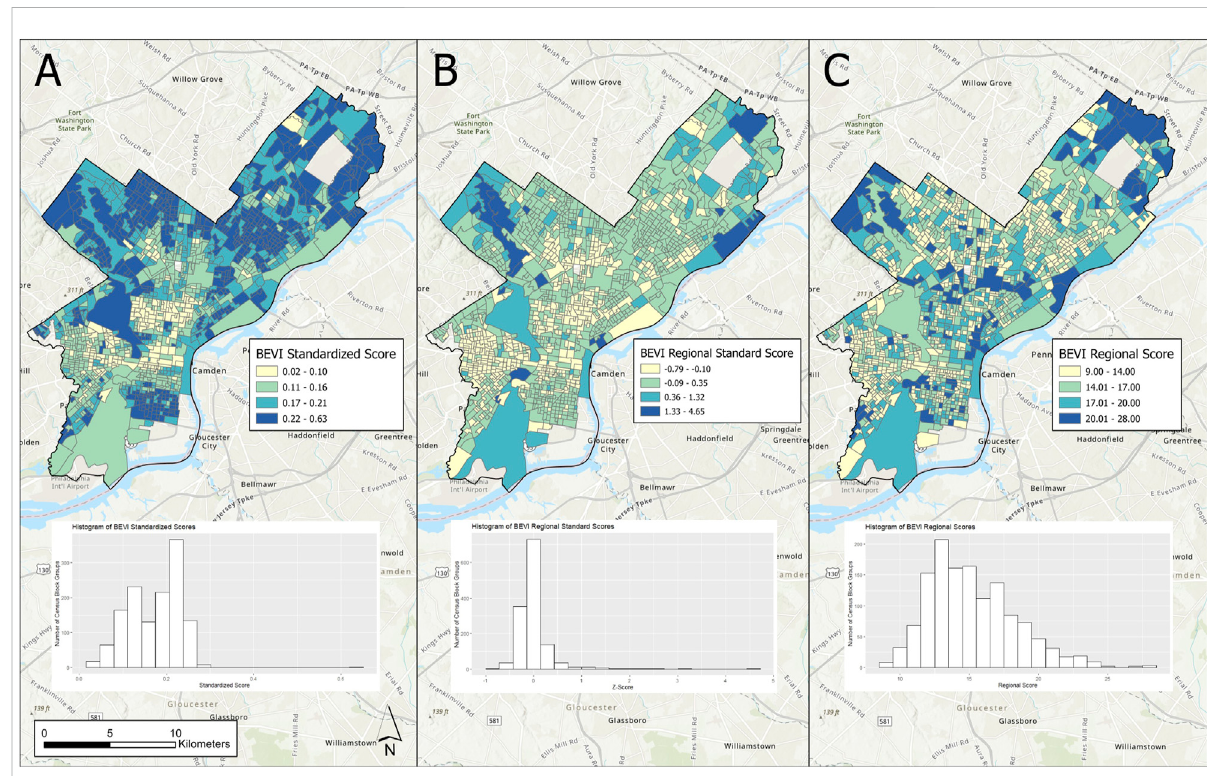
FIGURE 3 The analysis of the Built-Environment Vulnerability Index results. (A) The spatial distribution of the BEVI based on the standardized scoring method. (B) The spatial distribution of the BEVI based on the z-scores. (C) The spatial distribution of the BEVI based on the regional scoring